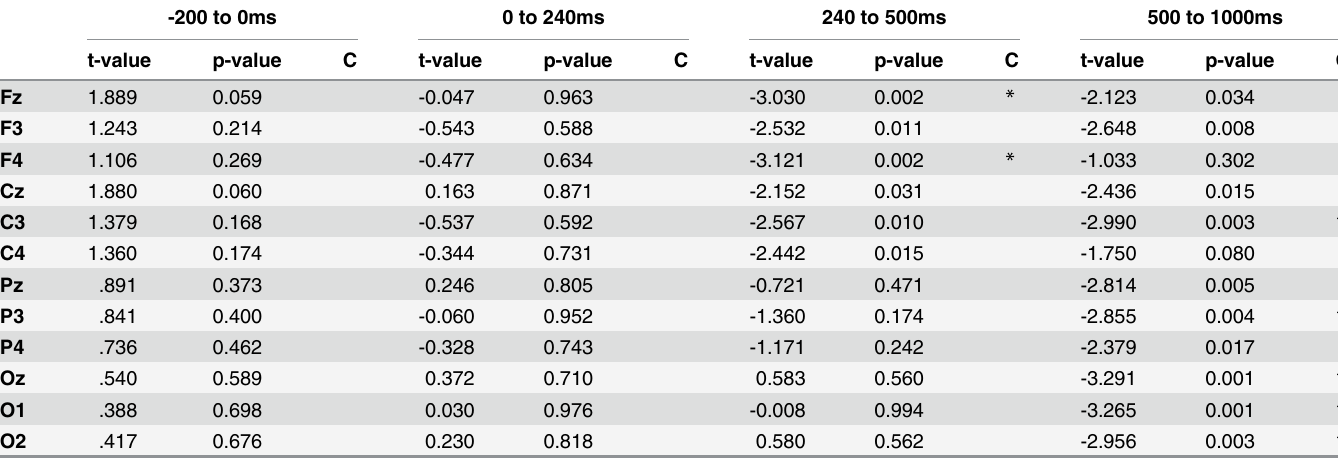
Table 2. T-values and p-values of the predictor; the interaction variable placement * exposure.